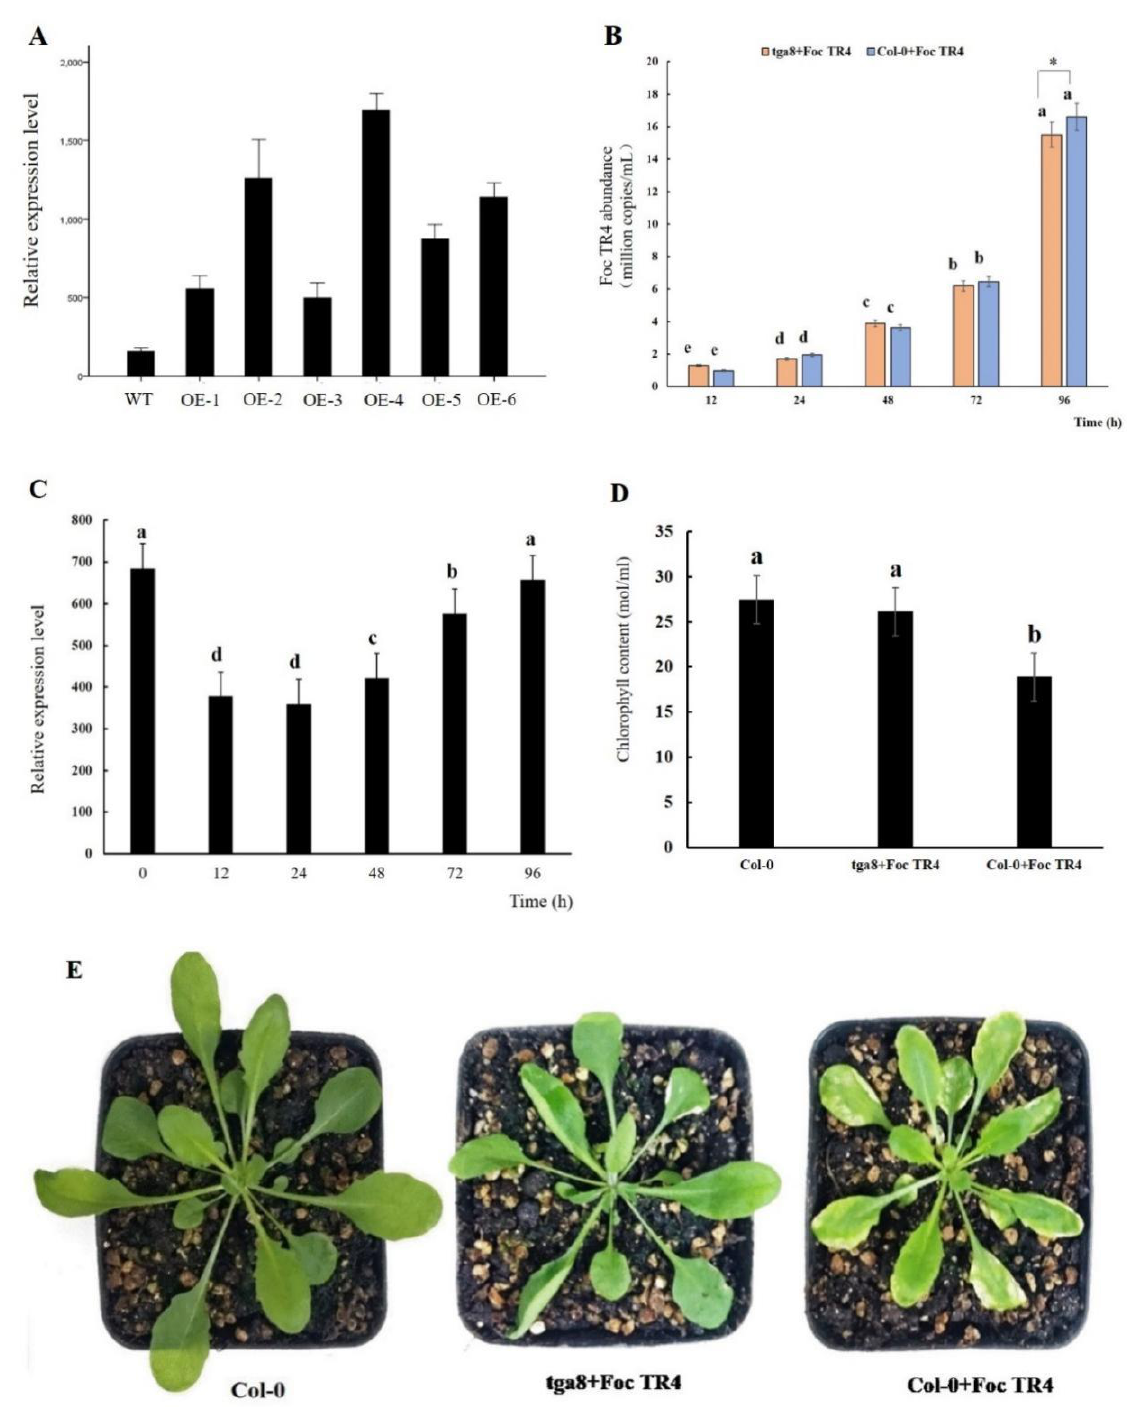
Figure 6. Improved Foc TR4 resistance in the transgenic Arabidopsis plants with the heterologous overexpression of MaTGA8 . The relative expression of transgenic MaTGA8 Arabidopsis in six randomly chosen lines ( A ). Foc TR4 abundance in Arabidopsis plants ( B ). Expression level of MaTGA8 in transgenic Arabidopsis after FocTR4 infection ( C ). Arabidopsis chlorophyll content ( D ). Phenotypes of transgenic Arabidopsis and wild-type Arabidopsis after Foc TR4 infection ( E ). Symbols a, b, c, etc., indicate a significant difference in the p values of 0.05.